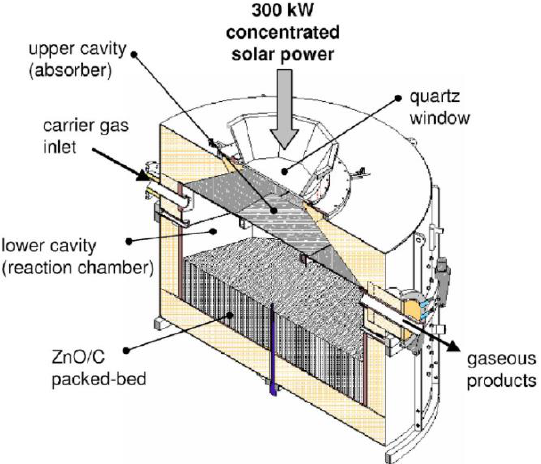
Figure 11. Scheme of the 300 kW (thermal) solar reactor designed for the carbothermal reduction of ZnO.